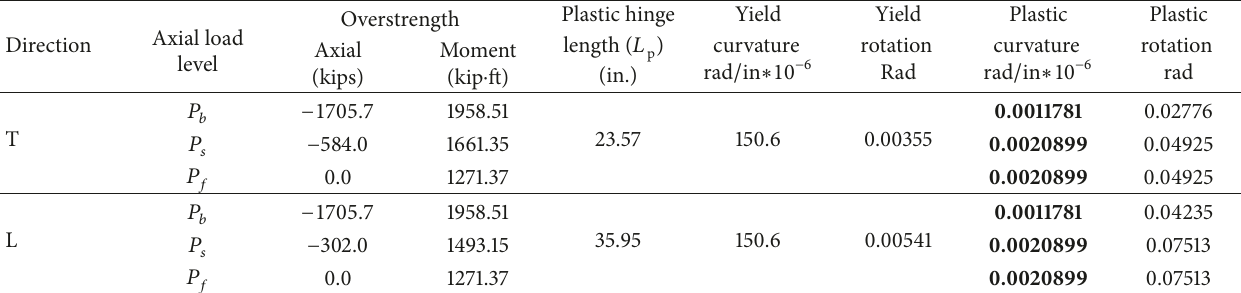
Table 9: User-defined plastic hinge properties of Pier #2 widened columns, Bridge